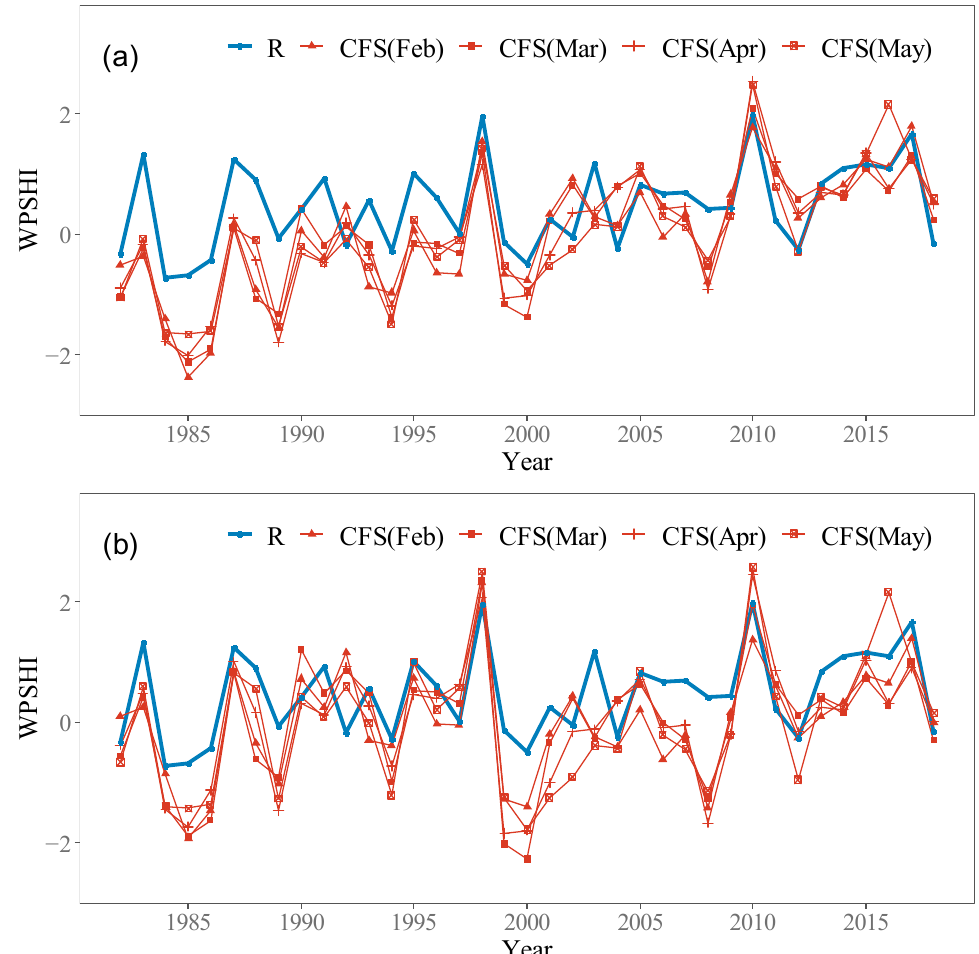
Figure 3. Comparison between WPSHI from reanalysis dataset (WPSHI(R)) and from CFSv2 (WPSHI(CFS)) with different released months. WPSHI (CFS) is standardized based on two different methods. ( a ) Standardized based on the mean and the standard deviation of 1982–2018. ( b ) For 1982–1998 and 1999–2018, the mean value of each period is subtracted respectively, then standardized by the standard deviation of the whole period, i.e., 1982–2018.